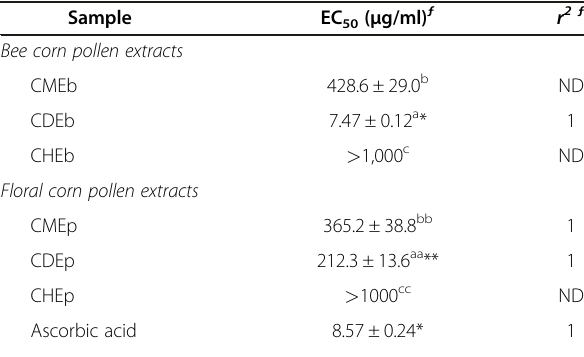
Table 2 The EC 50 values for the free radical scavenging activity of three different crude extracts from bee pollen and corn pollen, plus the reference standard (ascorbic acid) for comparison